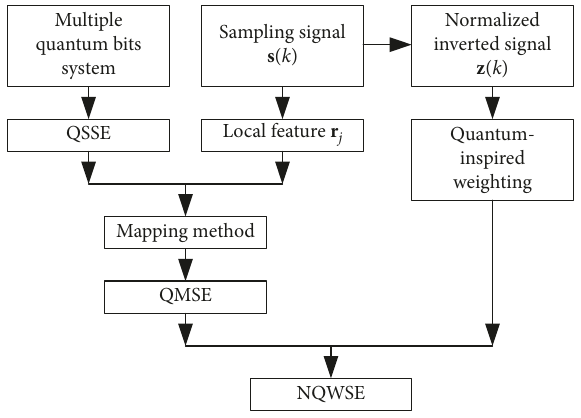
Figure 2: Generating process of the